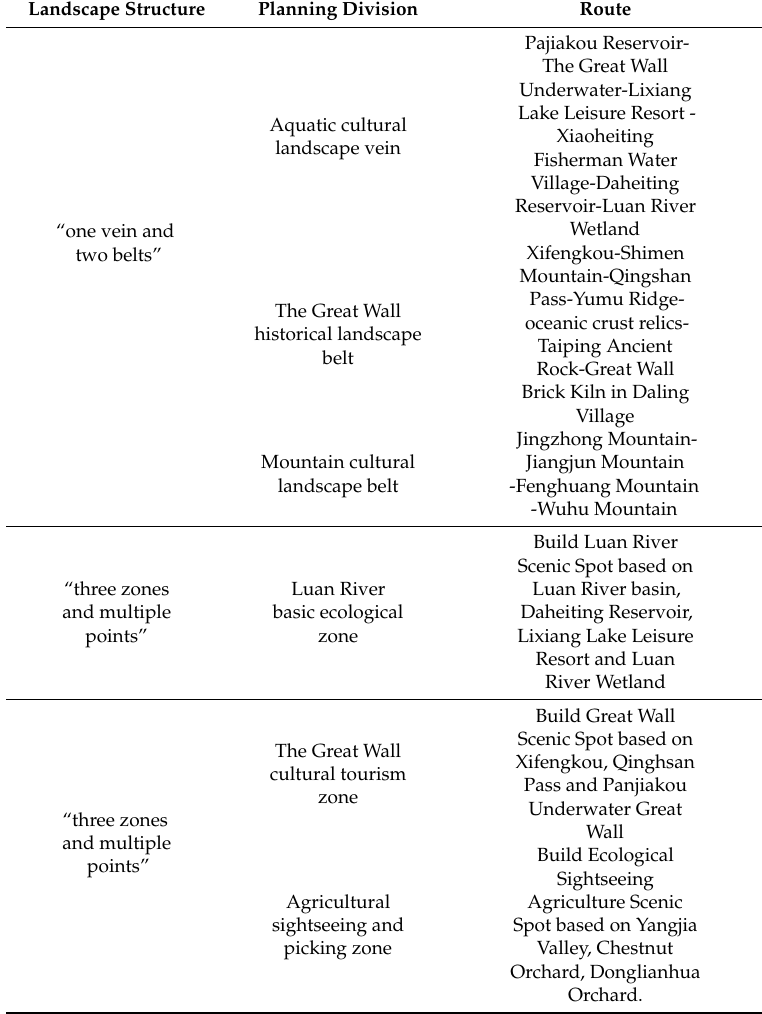
Table 6. County Landscape